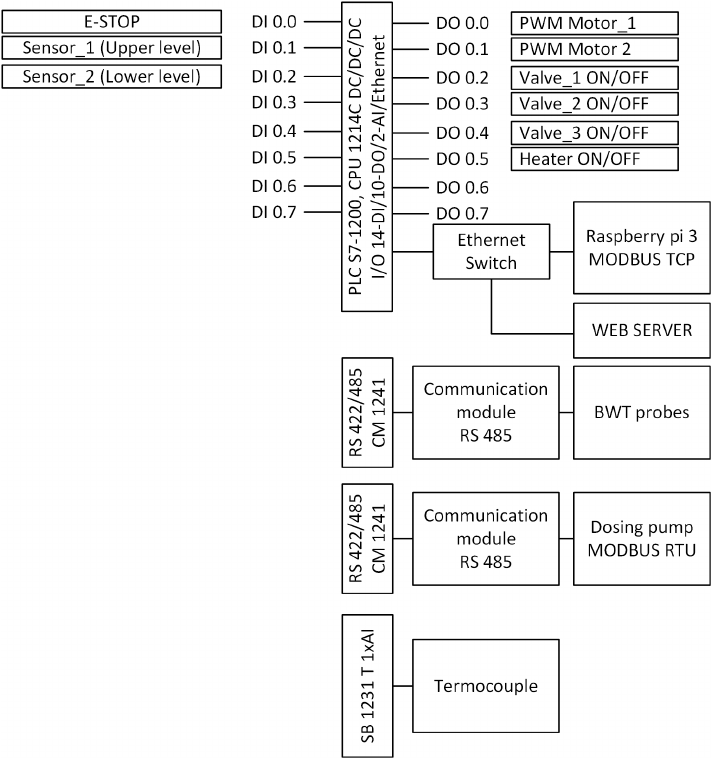
Figure 7. Description of PLC driver inputs/outputs (concept